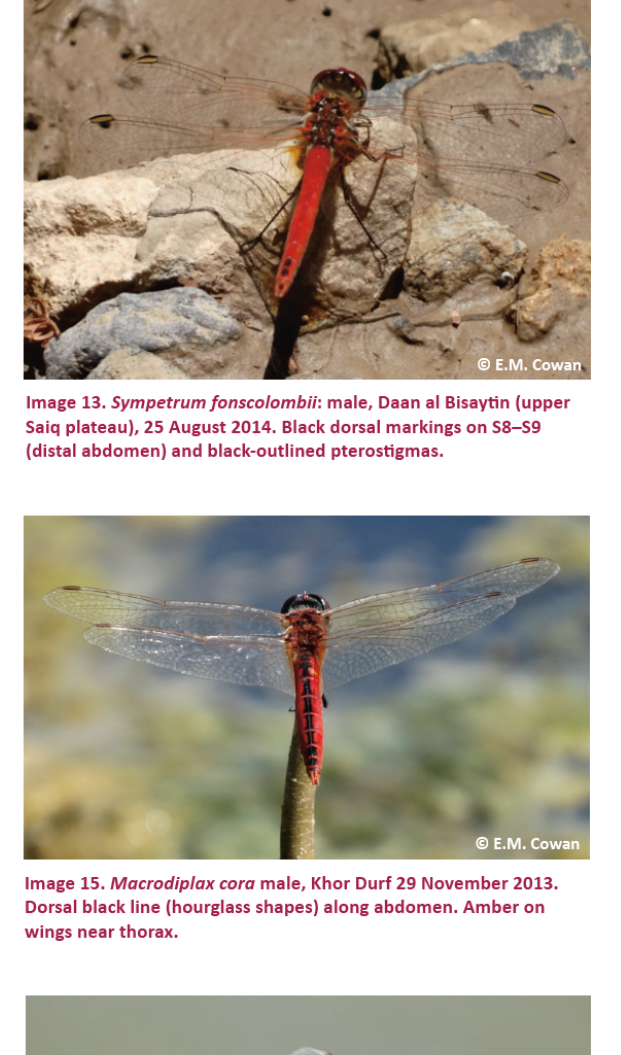
Image 16. Macrodfipflax cora: ovfiposfifing fin ftandem, Khor Durf, 4 Ocftober 2014.